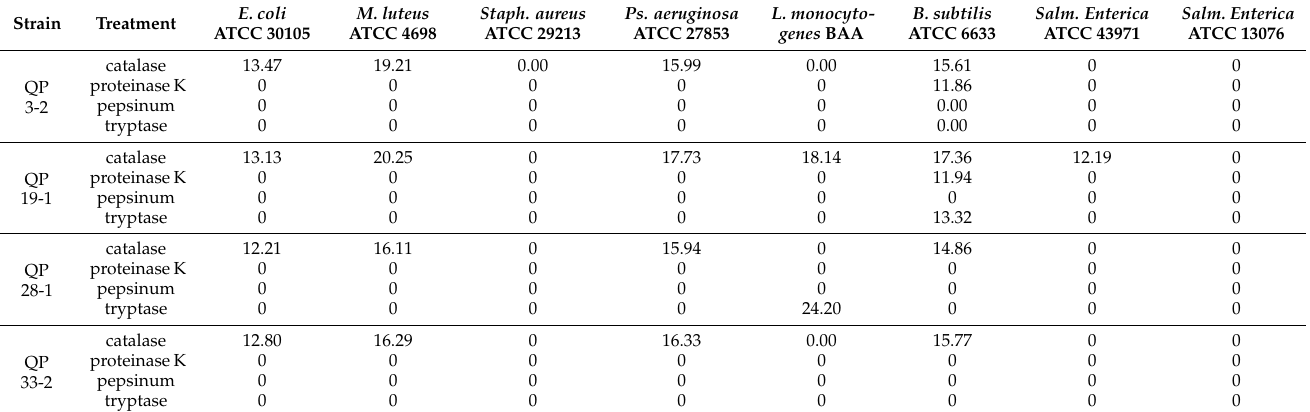
Table 2. The antibacterial activity of LAB strains after protease treatments.